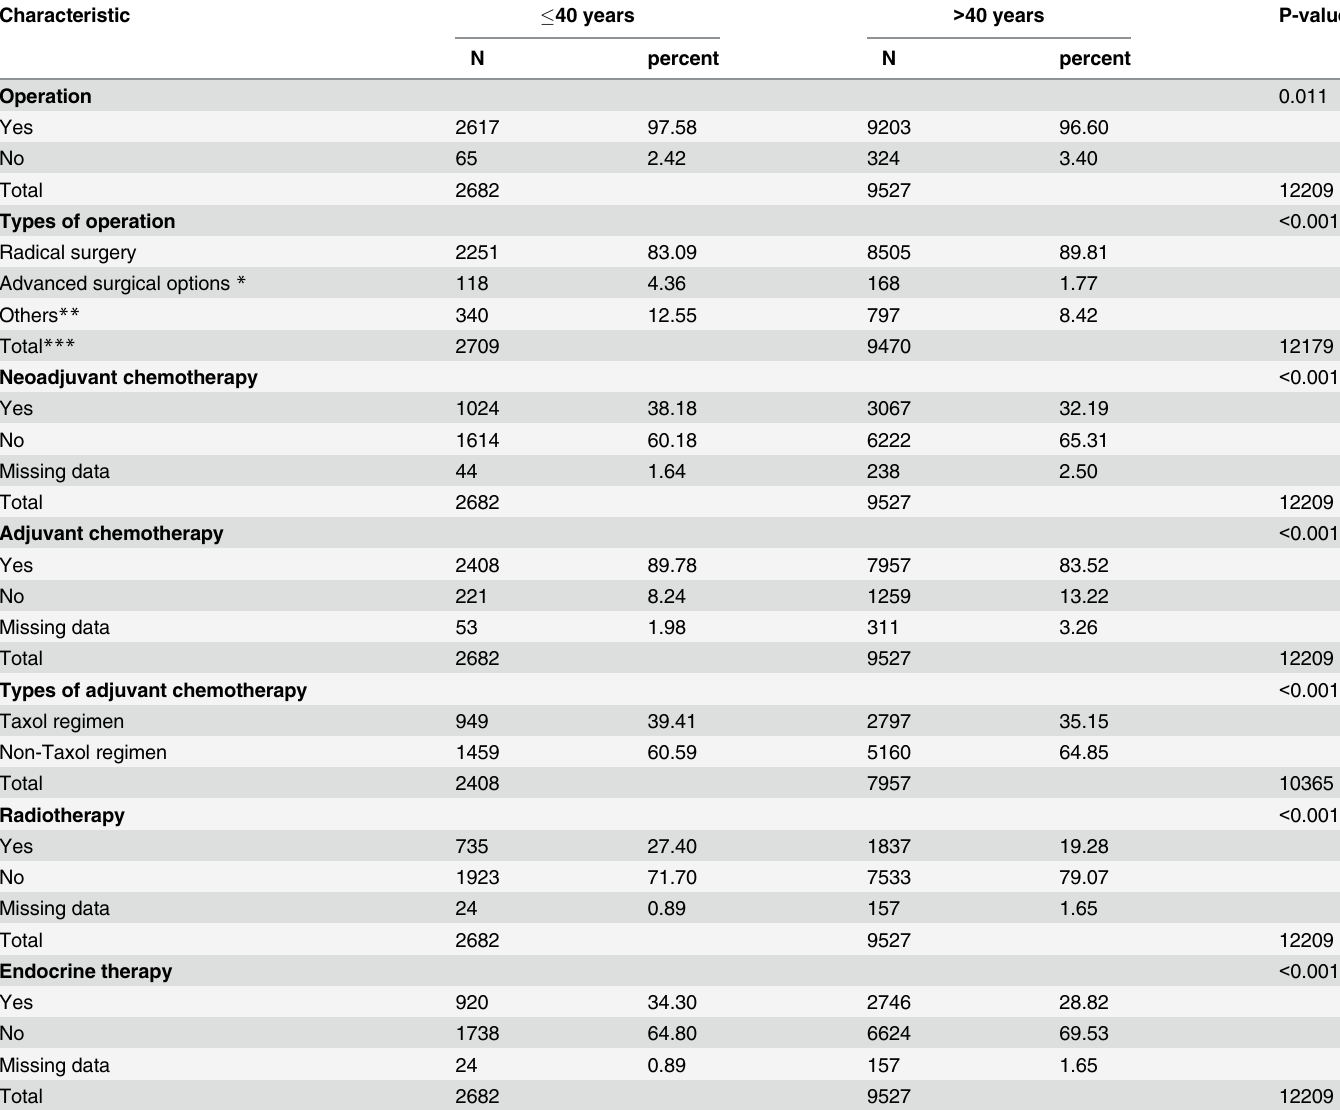
Table 3. Comparison of treatment modes between young ( (cid:1) 40 years) and older ( > 40 years) female breast cancer patients.